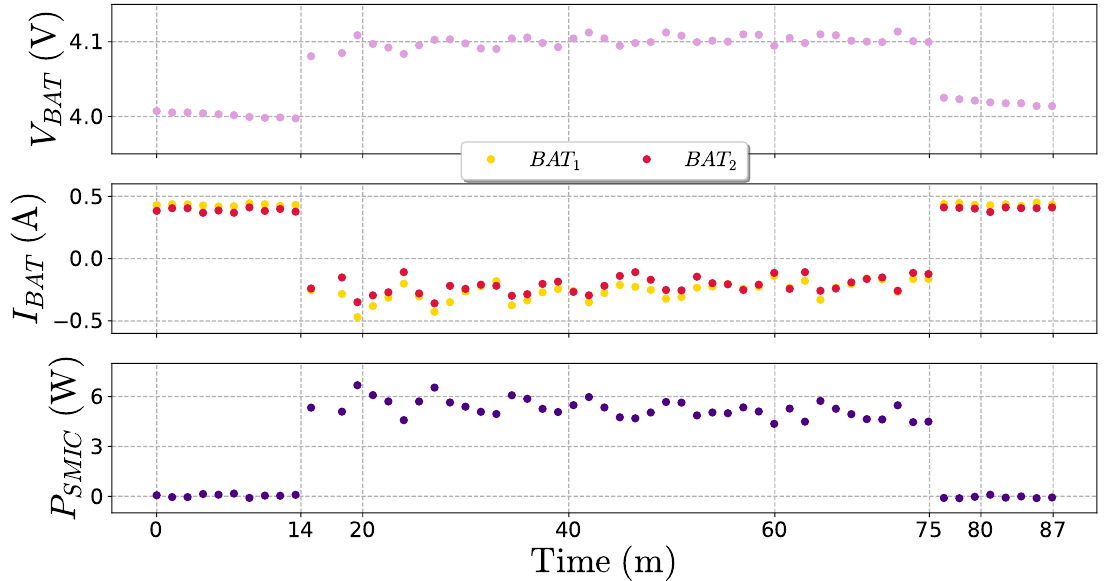
Figure 16. Battery voltage ( V BAT ), battery current ( I BAT ) and total generated power by the SMICs ( P SMIC ) during one orbit.